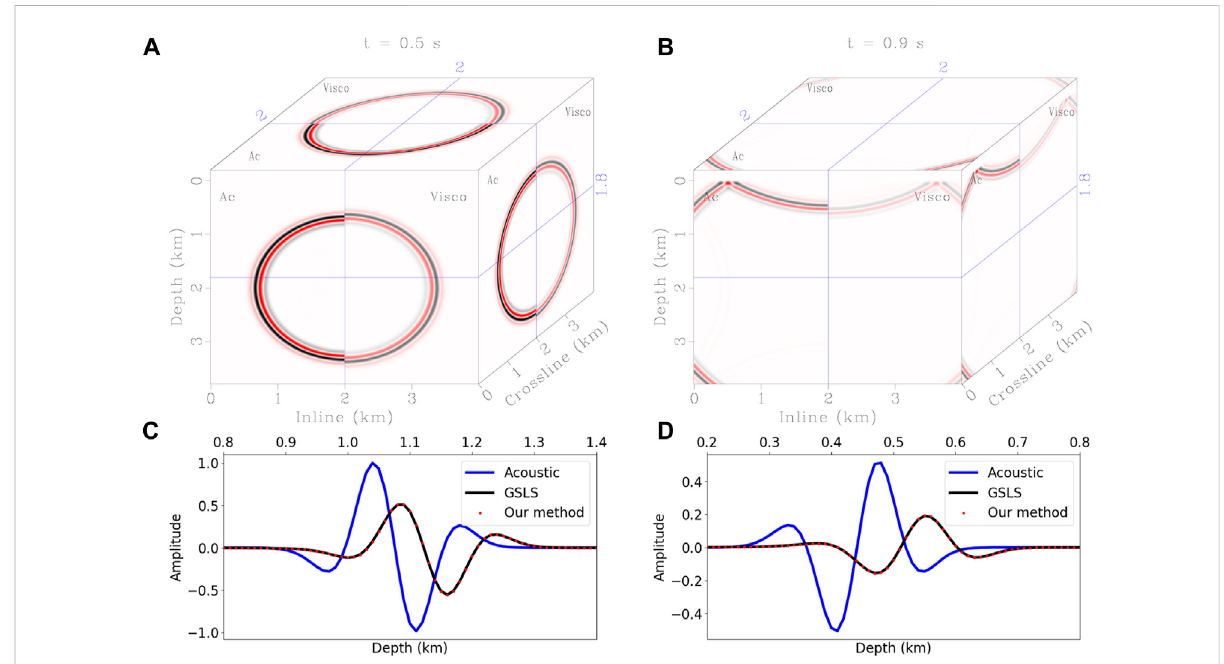
FIGURE 3 Comparison ofwave fi eldsimulationinahomogeneousmedium.Panels (A,B) areacoustic(Ac)andviscoacoustic(Visco)wave fi eldsat0.5 sand 0.9 s. Panels (C,D) are single-trace comparisons extracted from (A,B) . Blue solid lines denote acoustic results. Black solid lines denote viscoacoustic resultscomputedusingthegeneralizedstandardlinearsolid(GSLS)method,whichareusedasthereferences.Reddotlinesaretheresultscomputed using the proposed